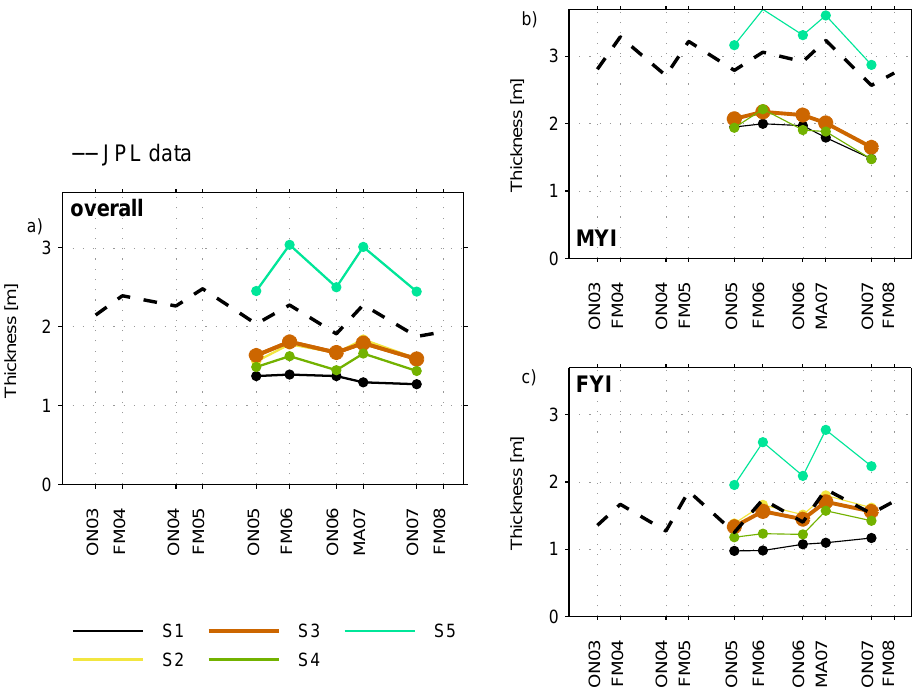
Fig. 5. Spatially averaged Arctic sea ice thickness calculated with different assumptions about snow depth. In (a) the total mean thickness is shown, in (b) the thickness of multi-year ice (MYI) and in (c) the thickness of first-year ice (FYI). Values are based on the available data sets described in Sect. 4.2, and can be found in Table 4. The brown line (S3) is the same line as D6 in Fig. 3. Table 4. Different assumptions about snow depth as used in this study to assess the possible range of sea ice thickness due to snow depth. Acronym Snow depth Description Used e.g.